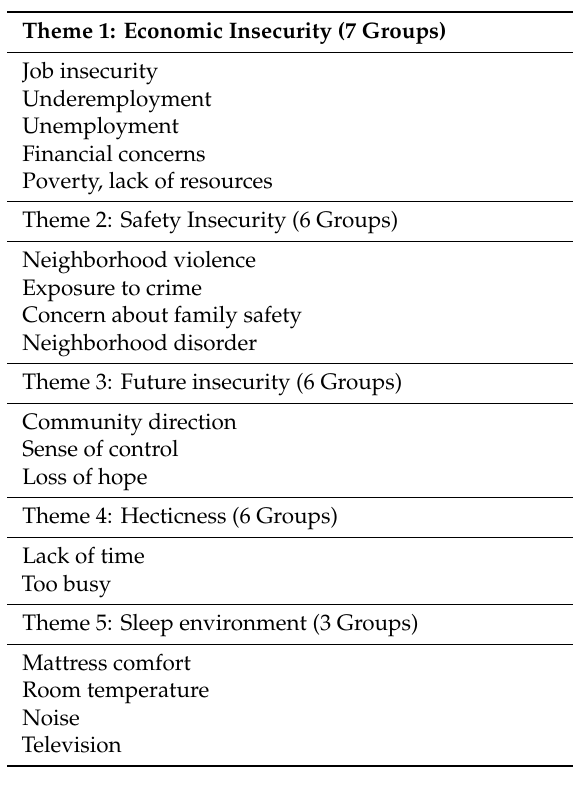
Table 2. Summary of